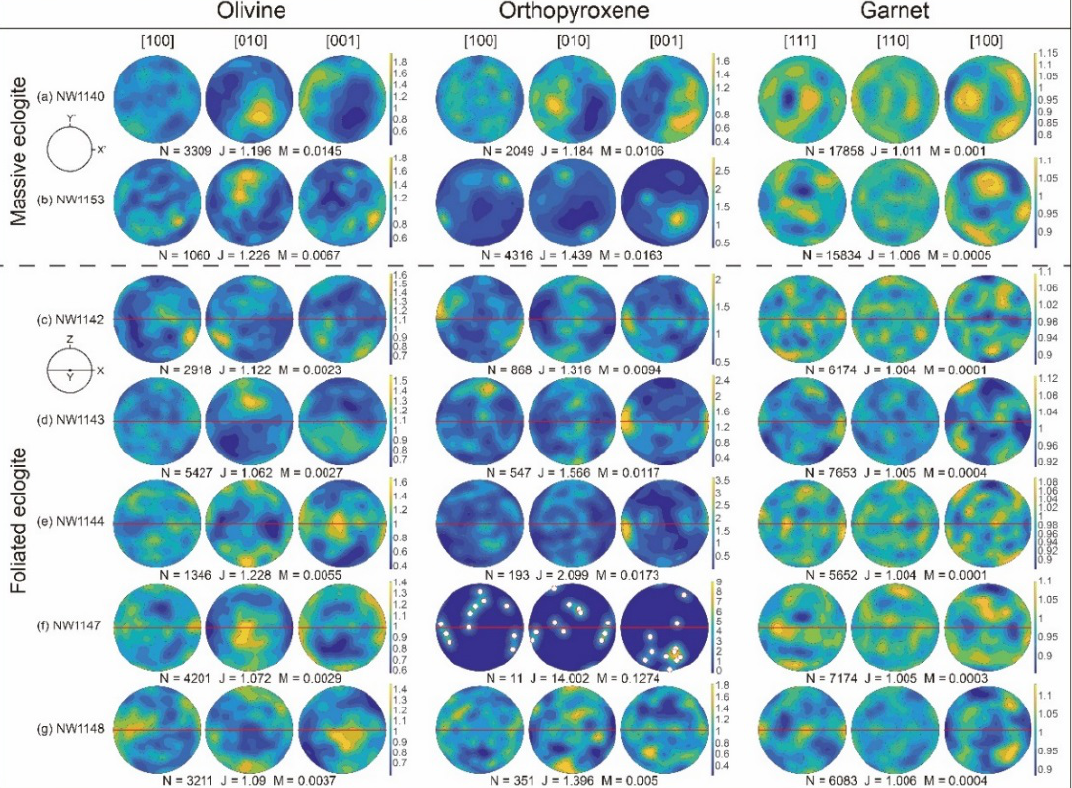
Figure 3. Crystal-preferred orientations (CPOs) of Ol (left column), Opx (middle column), and Grt (right column) in the MEC and FEC (modified from Cao et al. [42]). The pole figures are presented with an equal area, in the lower hemisphere, and contoured with a resolution of 1°. The superimposed circles in ( f ) are scattered orientations of Opx grains. X, Y, and Z denote the lineation, direction perpendicular to the lineation and parallel to the foliation, and foliation-normal direction, respectively. X’ and Y’ are the apparent lineation and the direction perpendicular to the lineation on the apparent foliation (X’Y’ plane). N: number of grains, M: M-index [45], and J: J-index [44].